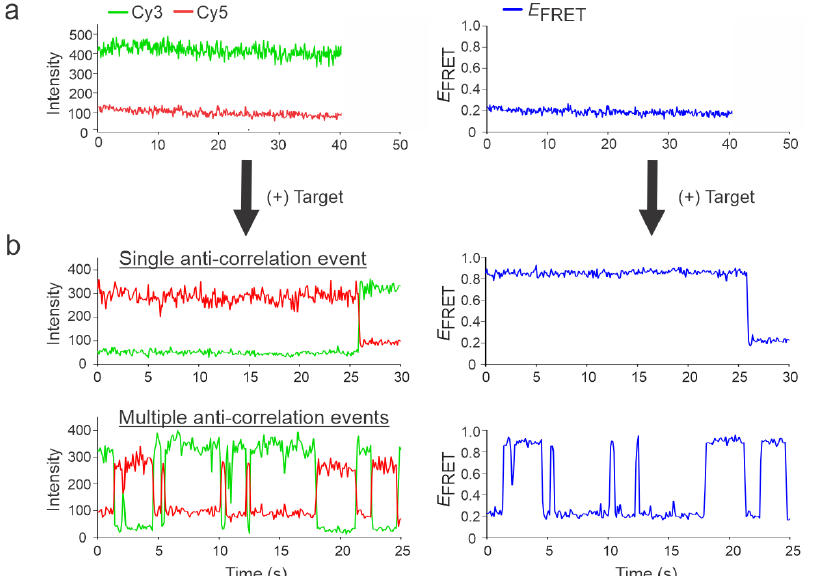
Figure 2. Representative intensity-time and E FRET -time traces in the presence and absence of the target. ( a ) No anti-correlation between the donor and acceptor fluorescence was observed in the absence of the target with a low FRET efficiency of ~0.2. ( b ) Addition of the target resulted in two types of traces: single anti-correlation events and multiple anticorrelation events, referred to as static or dynamic traces, respectively, along with an upward shift in the FRET efficiency of ~0.95. The data presented here belongs to the NT-0 sensor and its specific target, DNA92a.